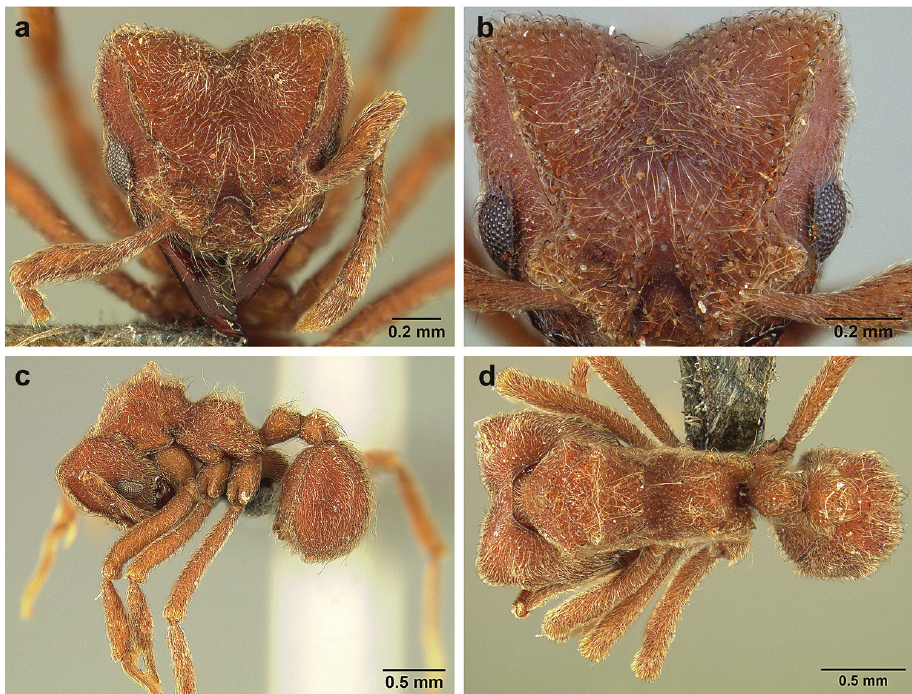
Figure 61. S. scrobifer worker (USNMENT01125115). a Head b head (detail) (USNMENT01125290) c lateral profile; and d dorsal